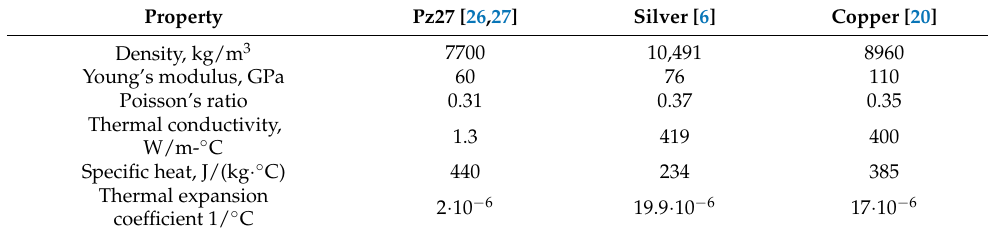
Table 2. Material properties used in finite element